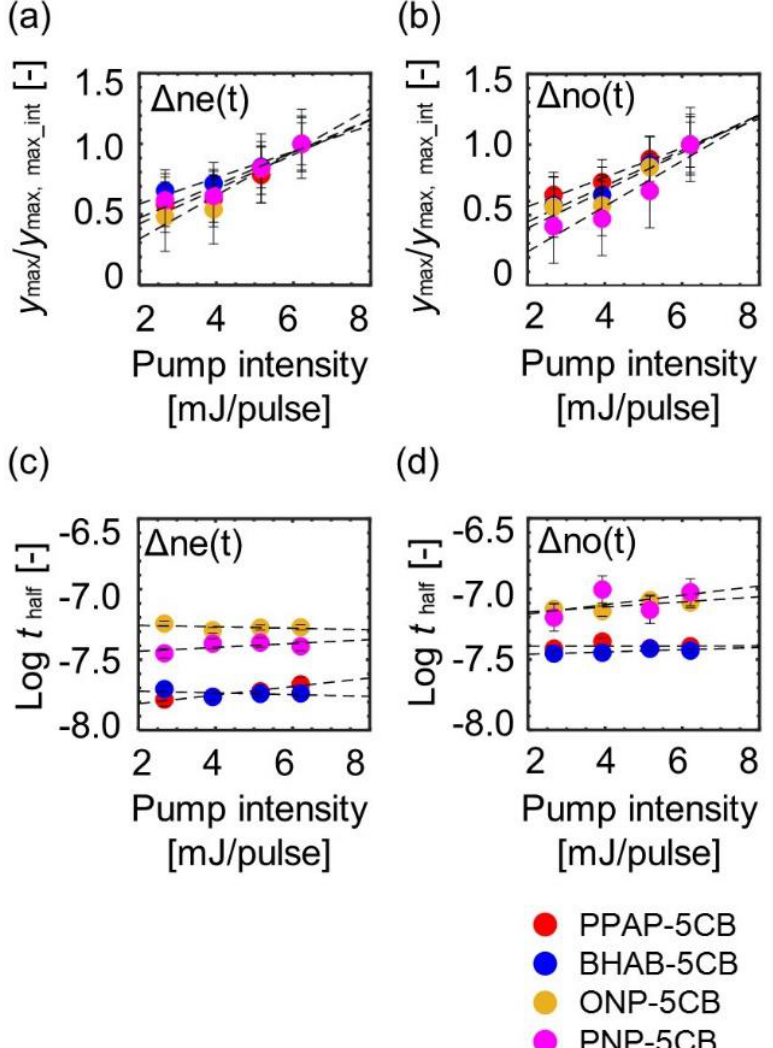
Figure 10. The parameter dependences on the probe polarization and the pump intensity: ( a , b ) the area parameters of the disordered region when the disordering processes finished, whose parameter values were divided by a pump intensity of 6.21 mJ/cm 2 ; ( c , d ) the log half-time for the disordering process. The pump light intensities were 2.67, 3.93, 5.16, and 6.21 mJ/pulse.